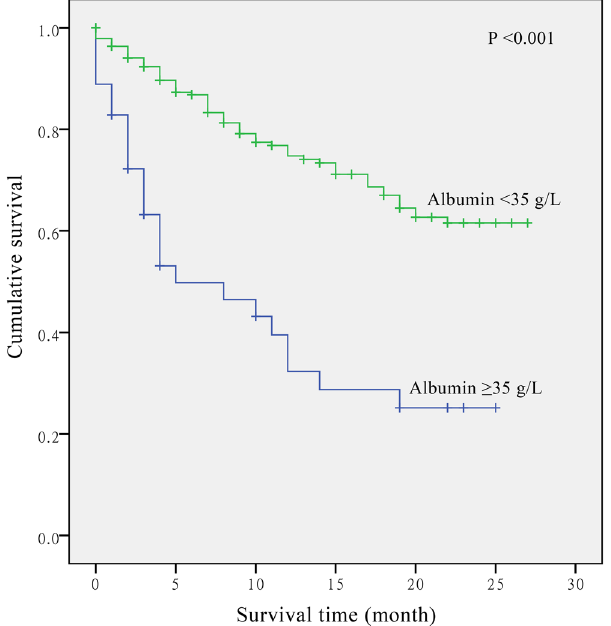
Figure 2. The relationship between albumin and overall survival in patients with non-small cell lung cancer.